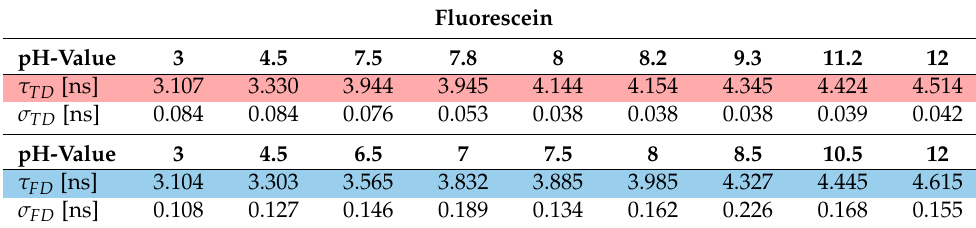
Table 6. Measured lifetimes for the pH-series in the TD and FD for fluorescein.